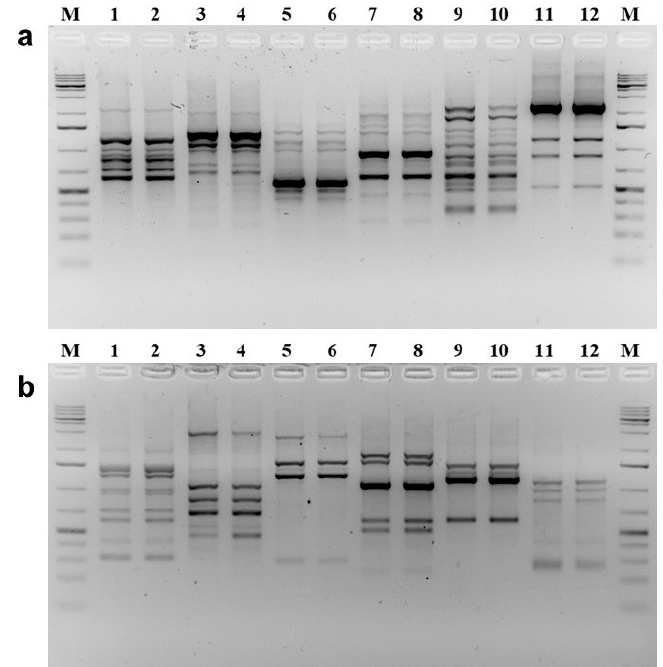
Figure 7. Genetic diversity of Neapolitan limmo and lemoncetta Locrese by RAPD molecular analysis. Comparison of the RAPD results on agarose gels of lemoncetta Locrese (odd lanes) and Neapolitan limmo genomes (even lanes), respectively, with the indicated arbitrary primers. ( a ) Lanes 1, 2: primer A05; lanes 3, 4: primer AK10; lanes 5, 6: primer AN10; lanes 7, 8: primer AX01; lanes 9, 10: primer AX08; lanes 11, 12: primer G07. ( b ) Lanes 1, 2: primer G12; lanes 3, 4: primer G19; lanes 5, 6: primer E10; lanes 7, 8: primer E11; lanes 9, 10: primer U4; lanes 11, 12: primer U19. Lanes M: GeneRuler 1 kb Plus DNA Ladder (Thermo Fisher Scientific) as molecular weight marker, containing three darkest bands consisting of 5000, 1500, and 500 bp.